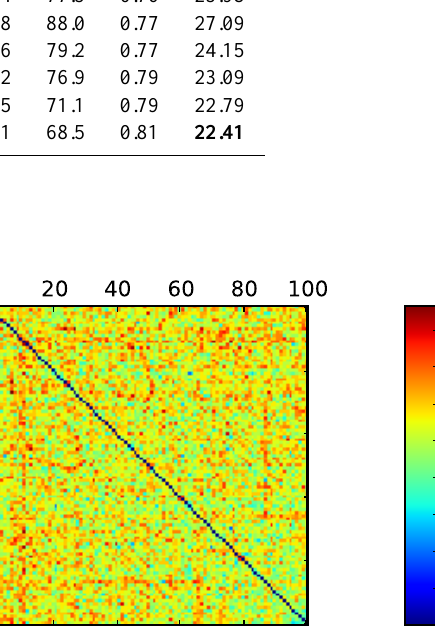
Fig. 4. Matrix of the number of different options between two mod- els. The models are sorted according to the RMSE (from the best to the worst